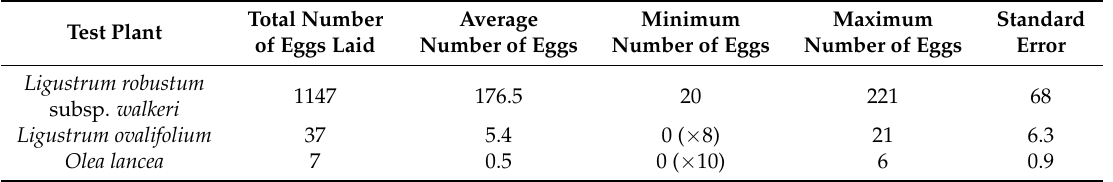
Table 6. The number of eggs laid by Epiplema albida on test plants in 12 multiple choice oviposition tests. In addition to these results, there was no oviposition in any of the 12 trials on Olea europaea subsp. europaea , O. europaea subsp. africana , Noronhia broomeana or N . emarginata . Total Number Test Plant of Eggs Laid